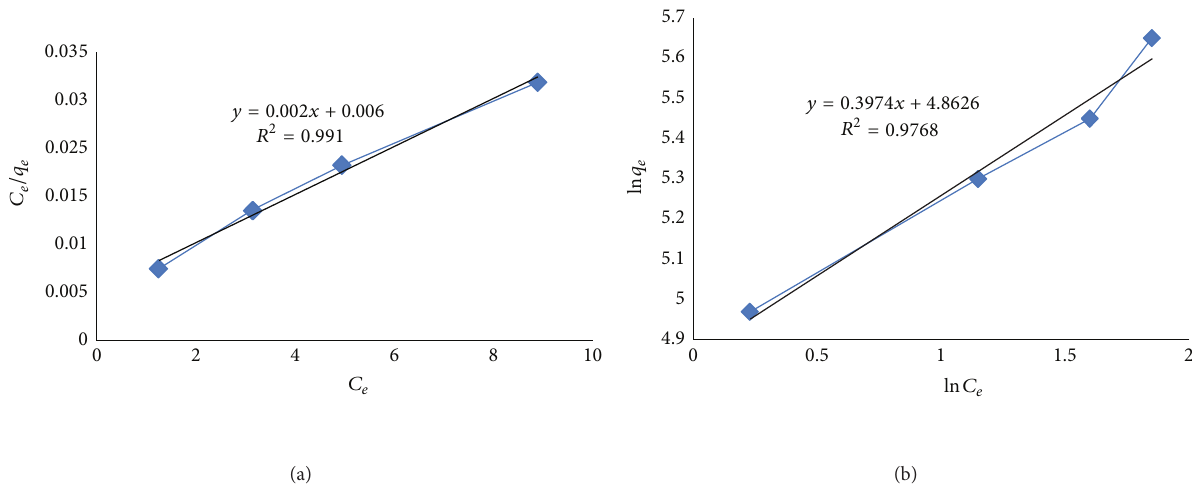
Figure 12: (a) Langmuir isotherm plots; (b) Freundlich isotherm plots for CV adsorption onto SBA-3 nanosorbent. Experimental conditions: sample solution, 25mL; solution pH, 9; amount of adsorbent, 15mg; contact time, 2min and initial CV concentration of 50–550 mg L −1 .